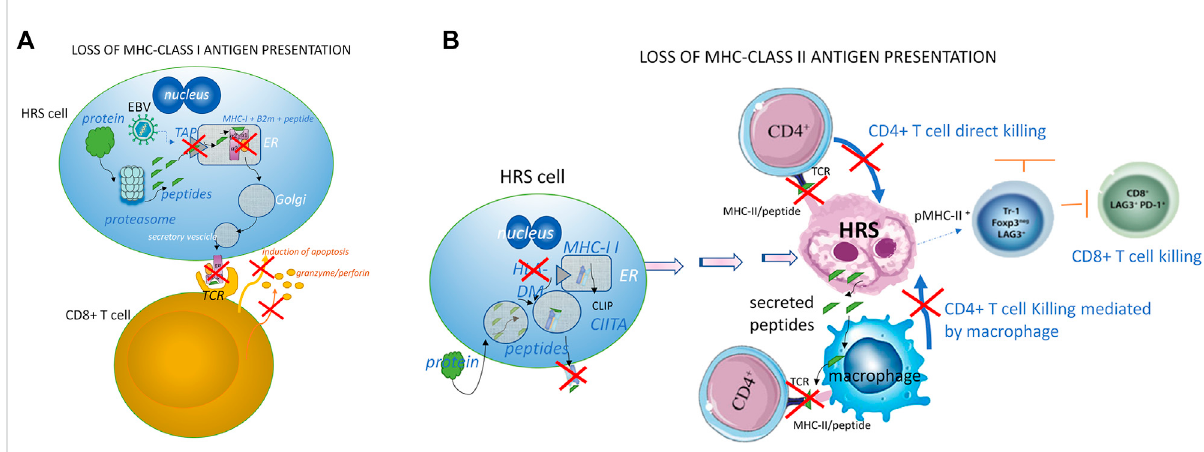
FIGURE 2 Loss of MHC class I (A) and class II (B) expression and MHC antigen presentation (A) A CD8 + cytotoxic T cell targets a cell expressing MHC-I/ antigen complex after intracellular proteins have been digested bythe proteasome into small peptides inHodgkinand Reed-Sternberg cells, but the surface expression of the MHC-I/peptide complex is reduced due to transporters of peptides like processing (TAP) carriers and the beta 2 microglobulin ( β 2m) chain. Both the induction of apoptosis and the release of granzyme/perforin by CD8-T cells are consequently inhibited. In normal conditions, the peptides translocate into the endoplasmic reticulum (ER), allowing the antigen to bind to MHC-I. Then, after a passage in theGolgistructureand packagingin secretory vesicles, theMHC-I/peptidecomplex isfused with theplasma membrane and exposed to thesurface of the target cell. The CD8 + T cell that recognizes and binds the MHC-I/peptide complex through its speci fi c T-cell receptor (TCR) can induce the death of the target cell by activating the classical apoptotic signaling (Fas/caspase) pathway together with the release of the cytotoxic granzyme B and perforin from T-cell granules. In the case of tumor cells infected by EBV, the EBV BNLF2a, BGLF5, and BILF1 proteins produced during viral replication reduce the expression of MHC-I -antigen complexes, and thus contribute to the CD8 + T cell immune escape of the infected cells. (B) Direct and indirect killing of target cells by CD4 + T cells. MHC-II alpha and beta chains are normally assembled in the endoplasmic reticulum (ER). MHC-II binds the human leukocyte antigen DM (HLA-DM) to protect itself from endosomal degradation. HLA-DM releases the class II-associated invariantchain peptide (CLIP), replacing itwith asequence-speci fi cpeptide. The complex MHC-II/peptide (pMHC-II) goes to thecell surface, where MHC-II can present the peptide to the CD4 + T-cells. After the recognition of pMHC-II through its T-cell receptor (TCR), the CD4 + T-cell may kill